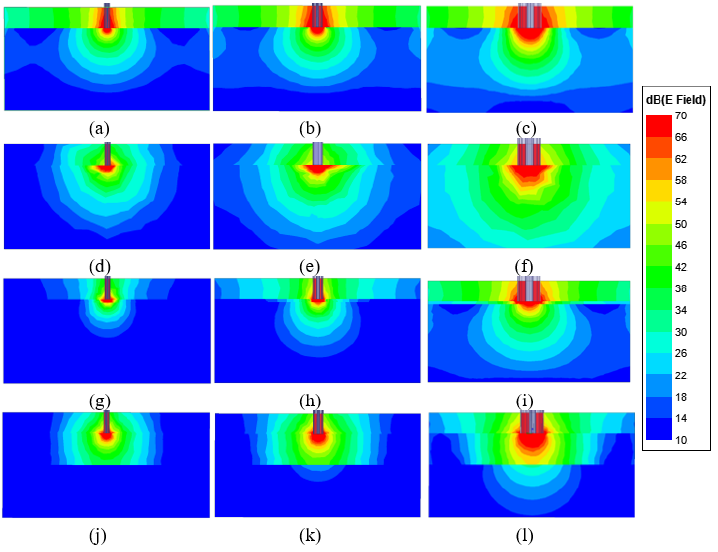
Figure 3. The electric field strength with 0.5, 0.9 and 2.2 mm diameter probes placed against single layer: ( a – c ) skin tissue layer, ( d – f ) olive oil layer, and double layer configurations: ( g – i ) olive oil layer with thickness of 0.3 mm and ( j – l ) olive oil layer with thickness of 3